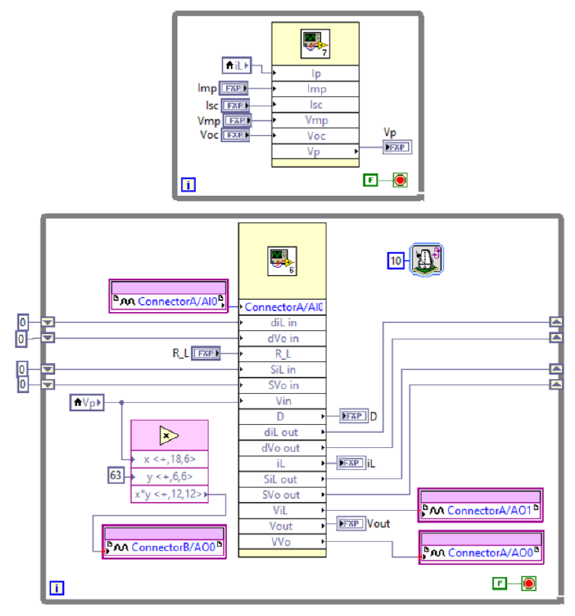
Figure 14. PVSE implementation.